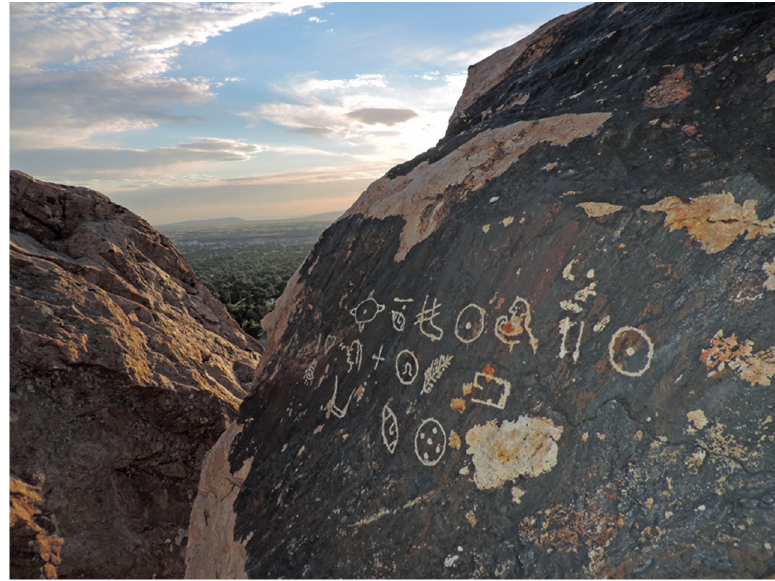
Figure 20. A classic Western Message Petroglyph text, Ogden, Utah.